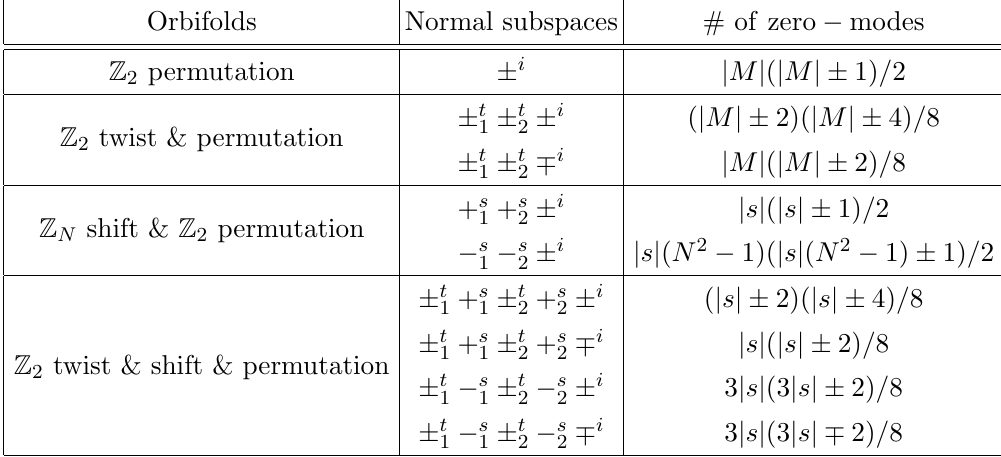
Table 4 . The number of zero-modes on each normal subspace for the ( T 2 and permutation orbifolds. The (cid:12)rst column shows the types of orbifolds. The second column shows the normal subspaces labelled by the Z 2 -twist eigenmodes (cid:6) t , the Z N -shift eigenmodes (cid:6) s and the Z 2 -permutation eigenmodes (cid:6) i for ( T 2 zero-modes on each normal subspace. The notation is same with table